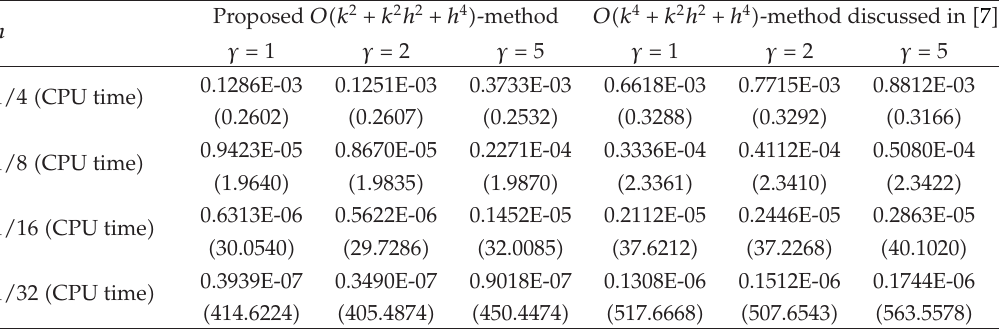
Table 6: Example 6.6: The maximum absolute errors (cid:4) with CPU time (cid:5) . h